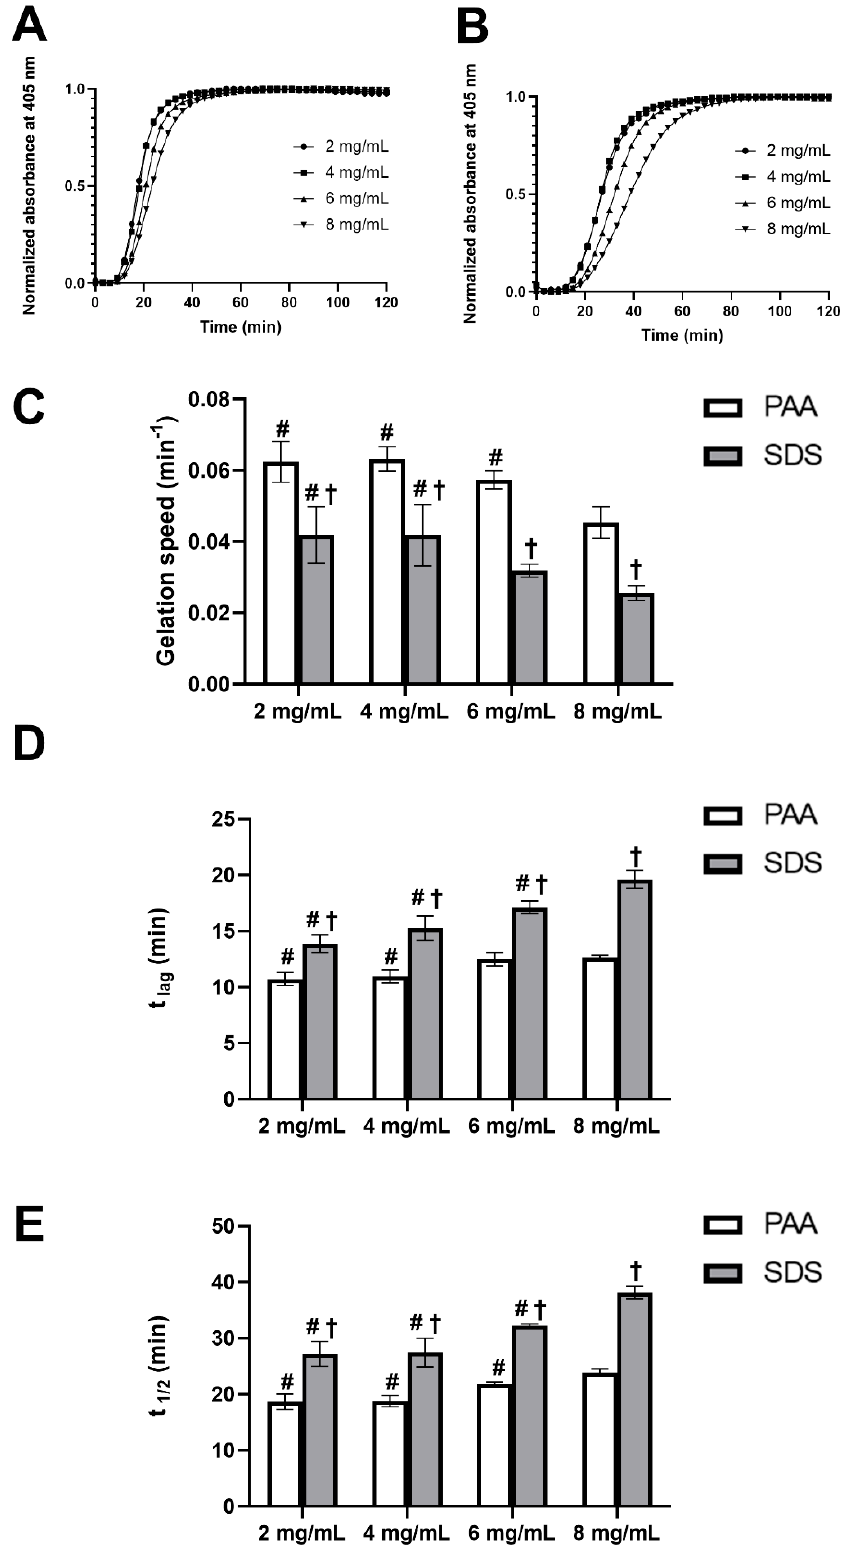
Figure 3. Turbidimetric gelation kinetics of UBM hydrogels. Normalized representative curves of UBM hydrogels from peracetic acid (PAA) ( A ) and sodium dodecyl sulfate (SDS) ( B ) decellularization methods. Speed ( C ), t lag ( D ) and t 1/2 ( E ) of UBM hydrogels. # denotes statistically difference from the 8 mg/mL concentration of the same decellularization group type, and † denotes statistically difference between PAA and SDS group at the same concentration ( n = 4) ( p < 0.05).